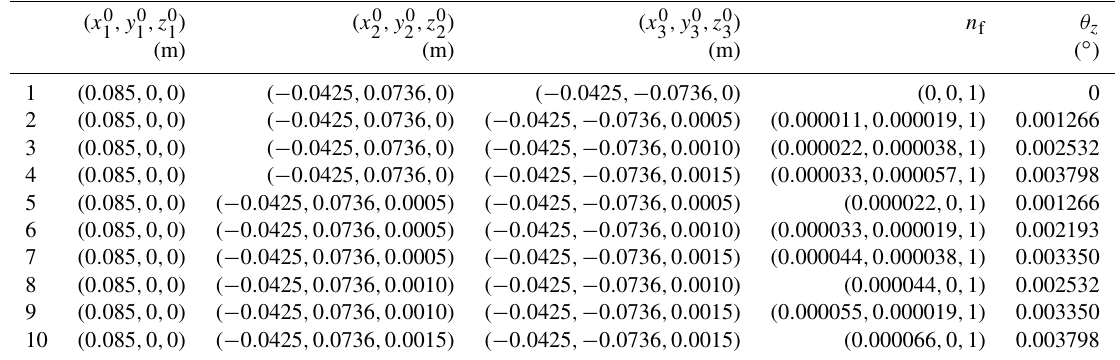
Table 3. Numerical analysis of the height variation